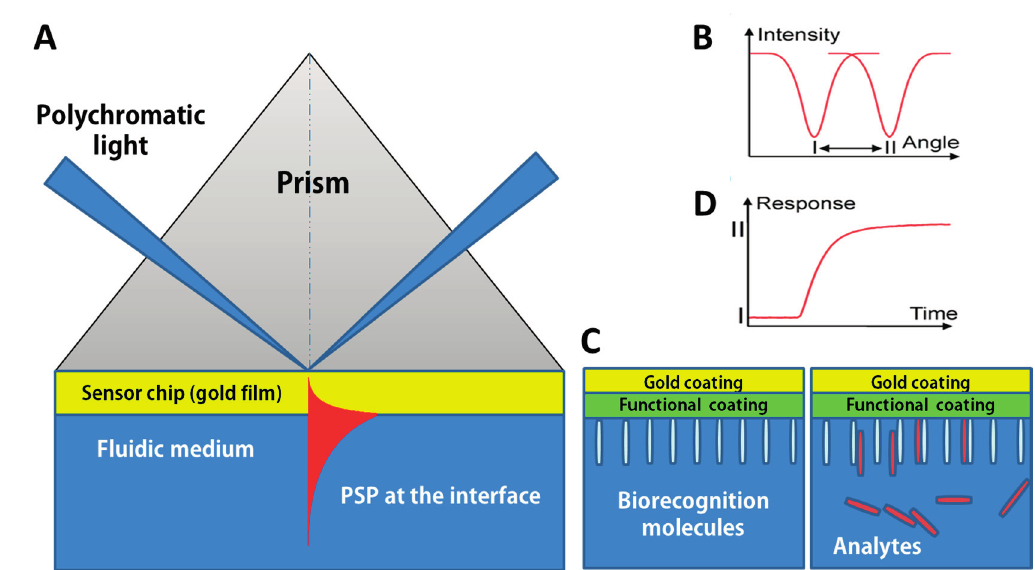
Figure 1. Concept of a surface plasmon resonance (SPR) biosensor: ( A ) Kretschmann geometry of the ATR method; ( B ) spectrum of reflected light before and after refractive index change; ( C ) analyte-biorecognition elements binding on SPR sensor surface and ( D ) refractive index changes caused by the molecular interactions in the reaction medium. Adapted from